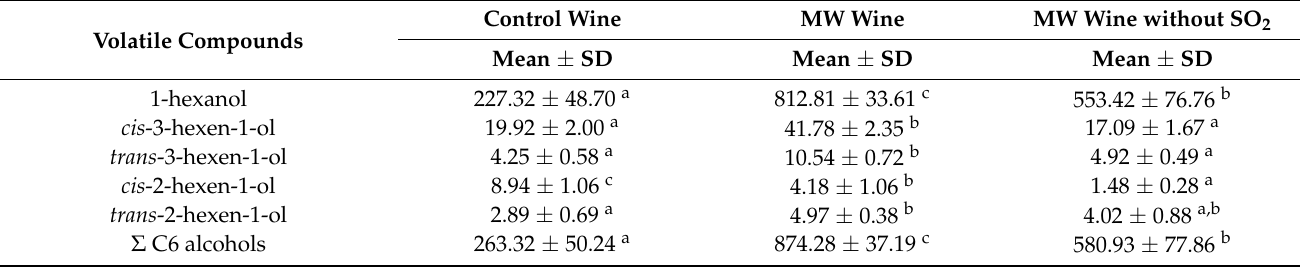
Table 1. Free volatile compound concentrations ( µ g/L) in control wines and those obtained from microwave-treated grapes elaborated with and without SO 2 ( n =